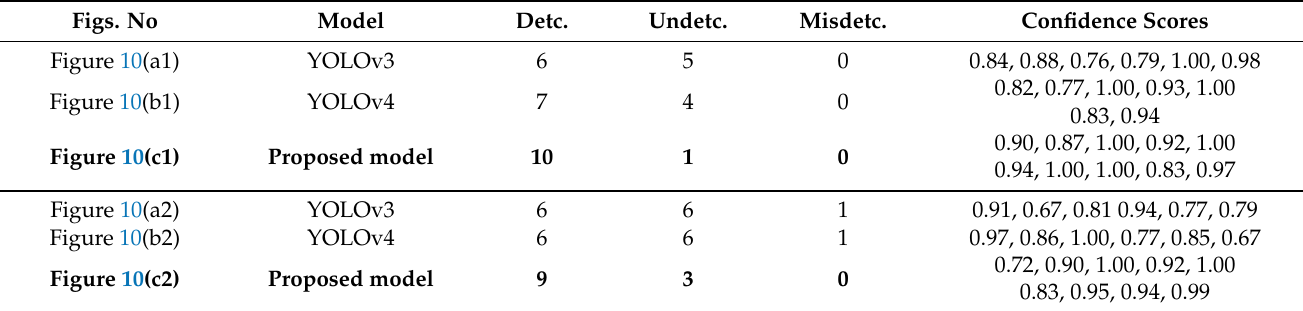
Table 8. Comparison of detection results between YOLOv3, YOLOv4, and proposed model for both apple scab and rust as shown in Figure 10. Bold highlights the best result obtained from corresponding model prediction.